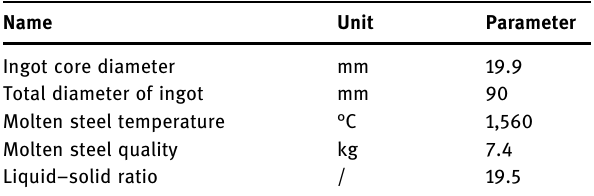
Table 4: Scale - down thermal experiment scheme